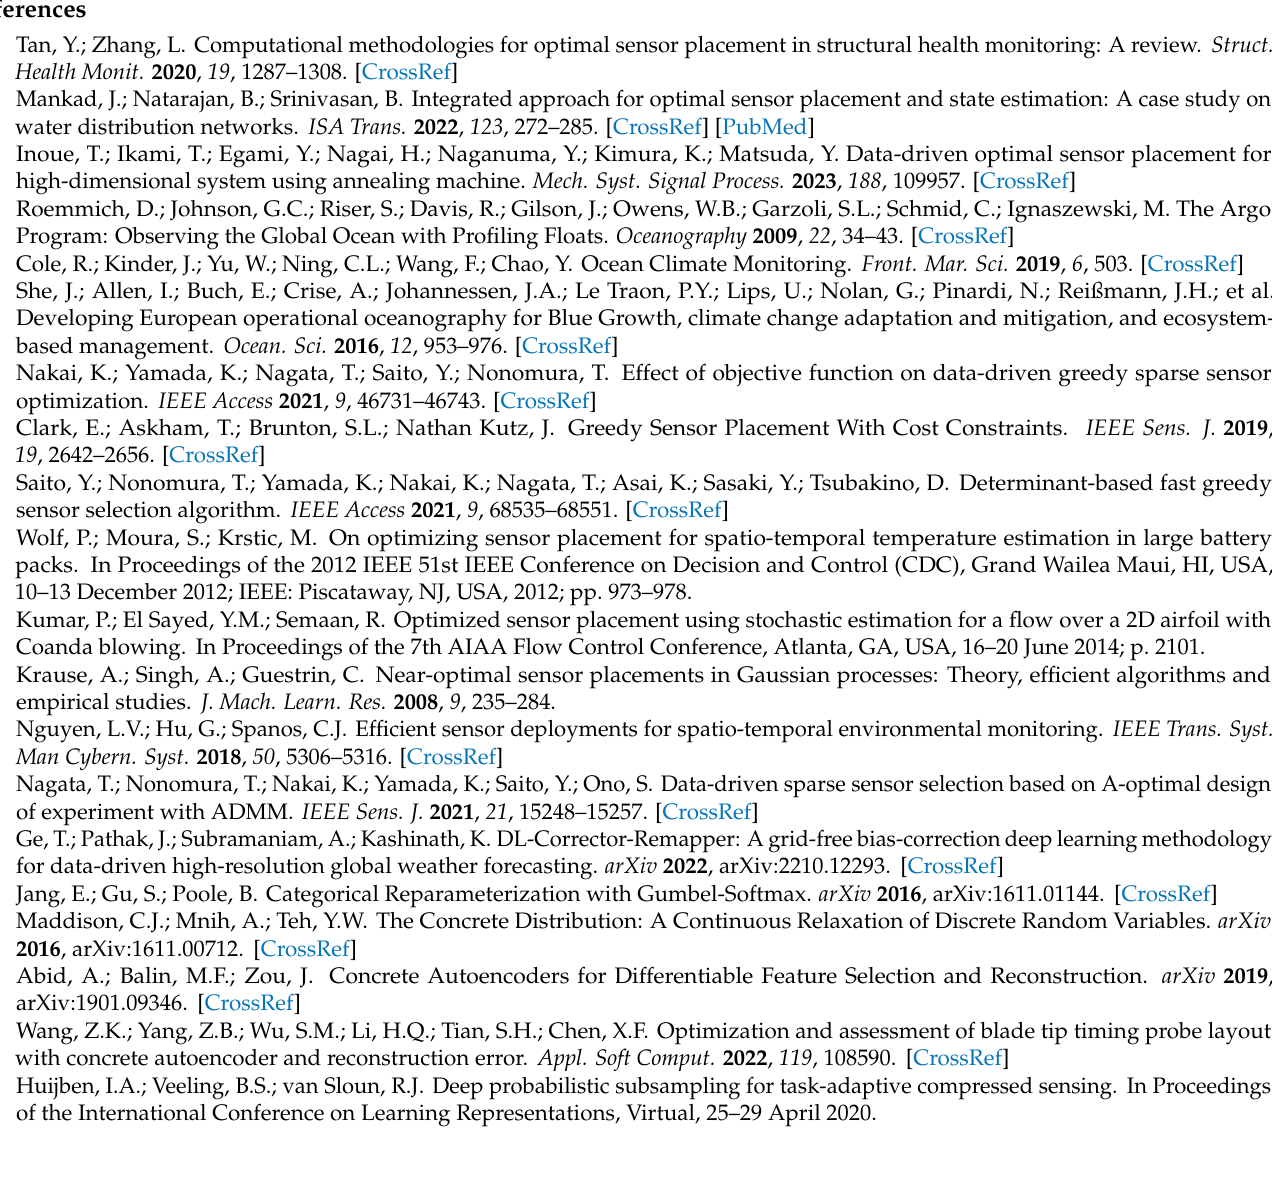
Figure A11. Spatial distribution of reconstruction RMSE by the Nearest Neighbor (NN) method from 8671 measurements with regular